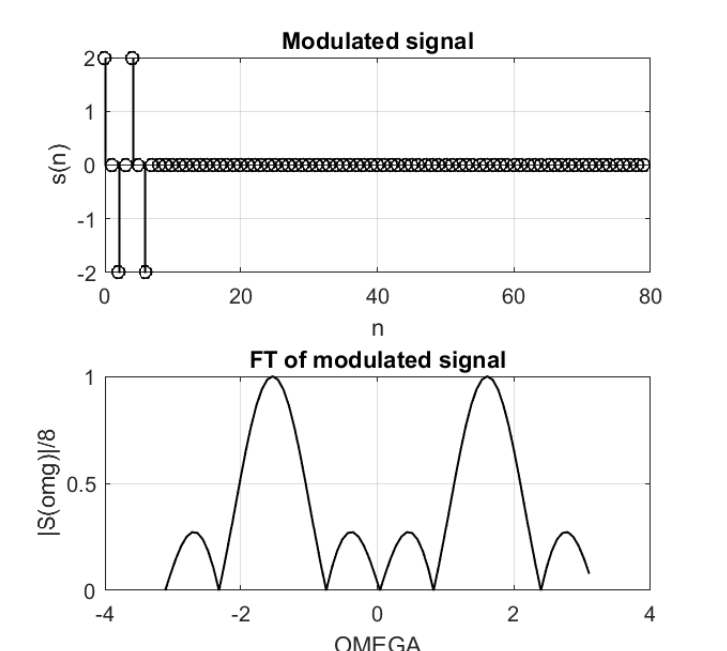
Figure 7 − Magnitude spectral density of the modulated signal in the time domain and in the frequency